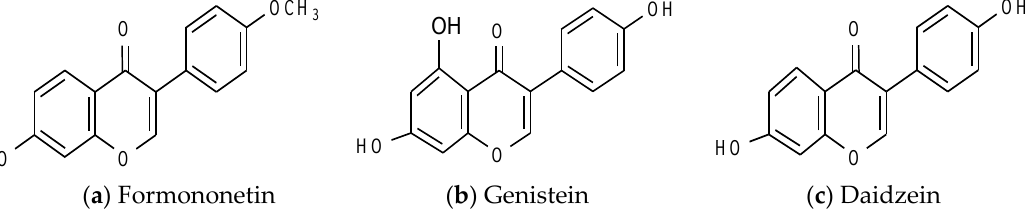
Figure 1. The chemical structures of ( a ) formononetin, ( b ) genistein, and ( c ) daidzein.